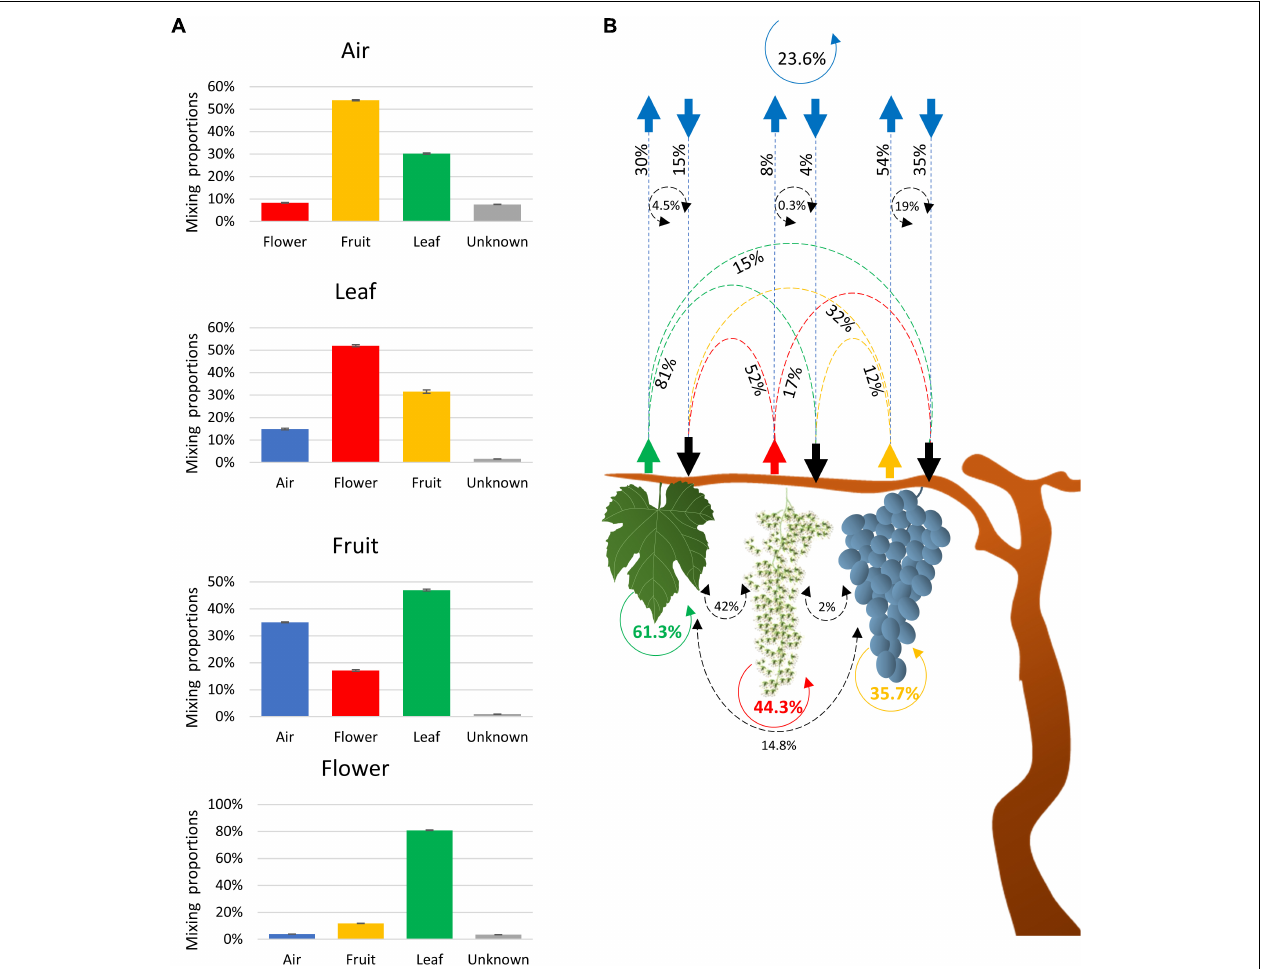
FIGURE 2 | Charts showing fractions of the estimated sources of fungal communities in each sink environment (air, leaves, and flowers/fruit) (A) and schematic description of the estimated source of the fungal communities associated with air and plant organs (B) . The scheme shows the estimated movement of communities originated from leaves (green dashed arrows), flower (red dashed arrows), fruit (orange dashed arrows), and air (blue arrows). Dashed black circle arrows indicate the percentages of community commonly exchanged between two environments. Solid colored circle arrows showed the percentages of community that retune to the same environment from all the other sources (B)